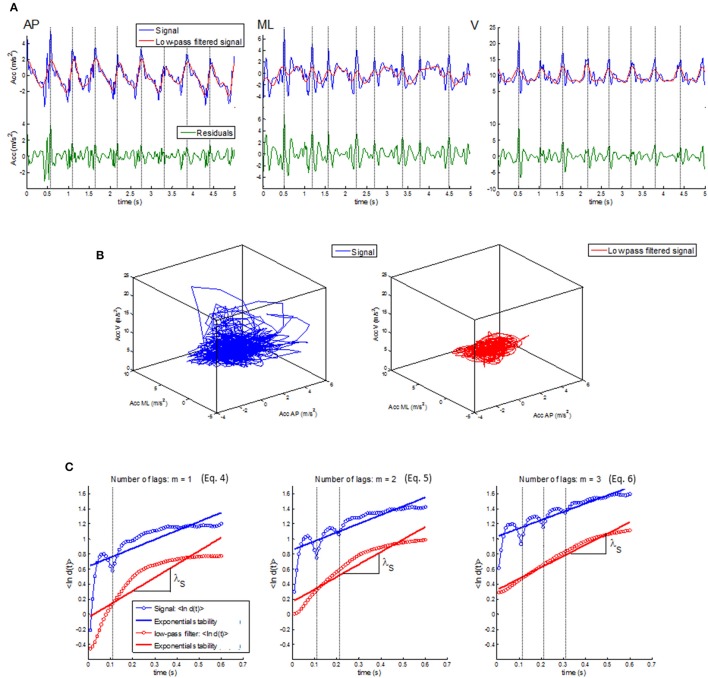
A representative example of the influence of within-step transitions in the gait dynamics on the non-exponential singularities in the reaction size d(t). (A) The trunk acceleration signal (blue trace) and low-pass filtered signal (red trace) for the anterioposterior (AP; upper left), mediolateral (ML; upper middle), and vertical direction (V; upper right). The green traces in the lower panels shows the corresponding high frequency residuals with step-to-step modulations generated by heel-strikes and push-offs (dashed vertical lines). (B) The reconstructed state space including AP, ML, and V direction for the trunk acceleration (blue trace in left) and the low frequency filtered signal (red trace in right). (C) The mean reaction distance, 〈ln d(t)〉, and the regression line, d(t) = d(0)exp(λt), for the trunk acceleration (blue dots and line) and the low-pass filtered signal (red dots and line) for reconstructed state space by Equations (4–6) for m = 1, 2, and 3 lags, respectively. The singularities in 〈ln d(t)〉 vanish in the low-pass filtered signal when the within-step transitions are removed. Notice that the singularity for the trunk acceleration for each of the m lags appears at time t = ml/Δt where l is the lag size of the state space reconstruction and Δt is the sampling frequency.